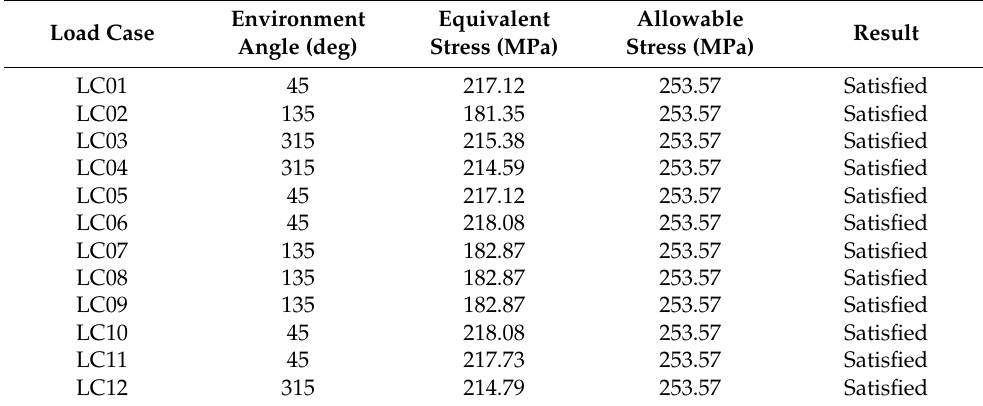
Table 15. Maximum equivalent stresses of the plates.